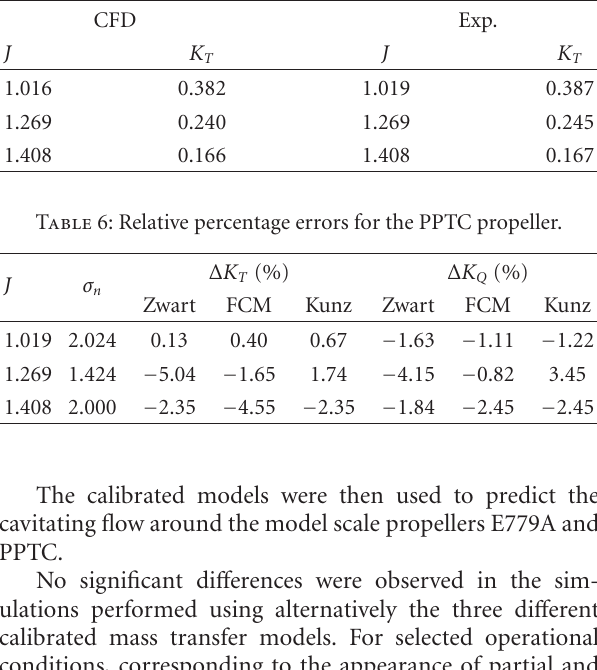
Table 5: Fulfil of thrust identity ( K T non-cavitating) for PPTC propeller. CFD Exp.